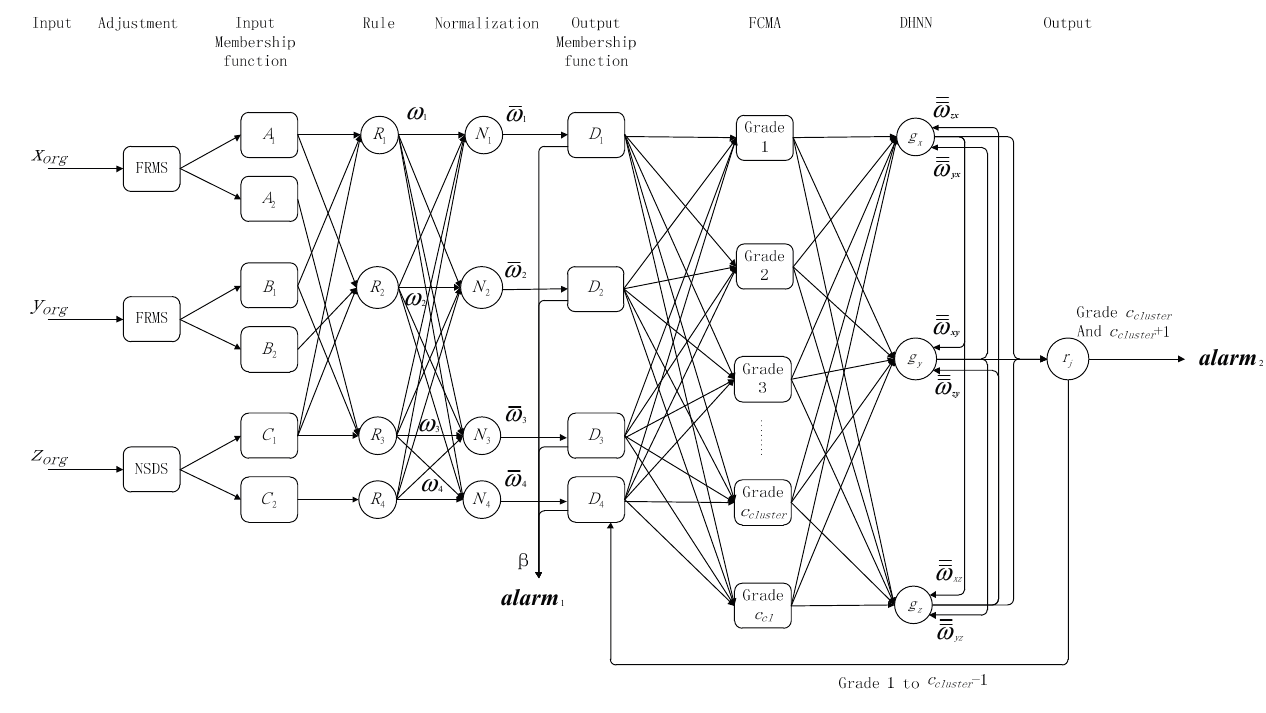
Figure 6. AF - DHNN